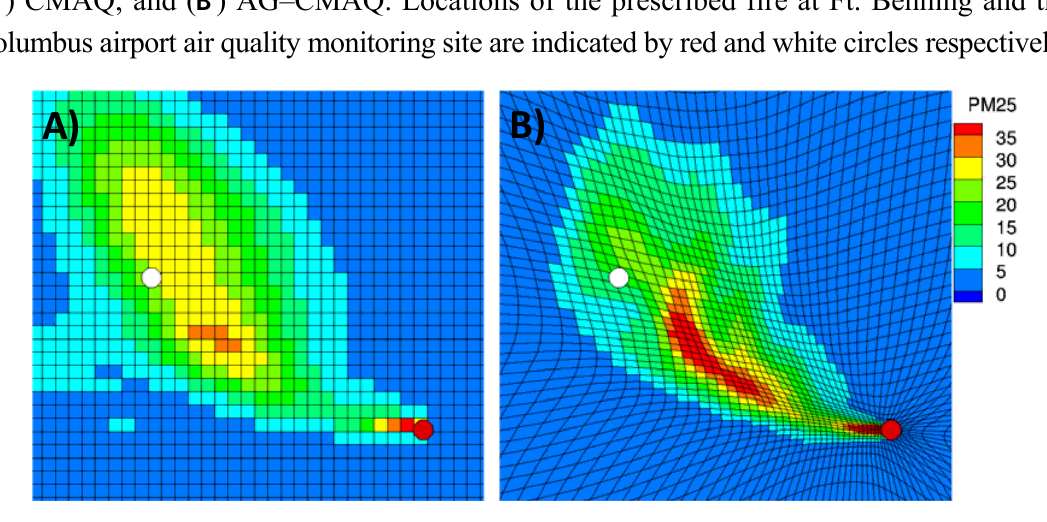
concentrations ( μ gm − 3 ) on April 9, 2008 at 2.5